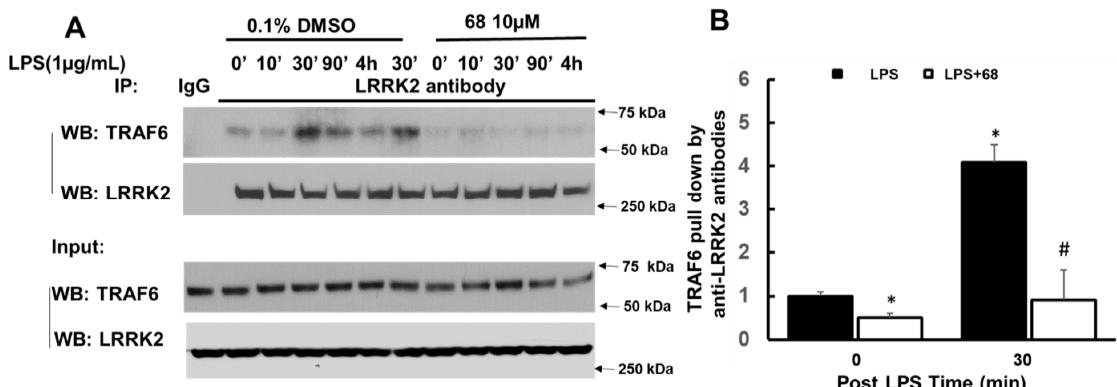
Figure 4. Compound 68 reduced LPS-induced TRAF6 and LRRK2 interaction. Human lymphoblasts were incubated in serum-free medium for 12 h and then exposed to LPS (1 µg/mL) with or without pre-treating 68 (10 µM) for 2 h, then kept treatment for various time periods as indicated. Cell lysates were harvested at the indicated time points after LPS exposure, then were subjected to co-IP assays using an anti-LRRK2 antibody, followed by anti-TRAF6 and anti-LRRK2 immunoblotting. LRRK2 antibody pulled down TRAF6. LPS increased LRRK2 interaction with TRAF6, while 68 attenuated this interaction. ( A ) Representative blots from the three separate experiments. ( B ) The quantification of LRRK2 interaction with TRAF6 at 30 min post LPS exposure (peak time). * p < 0.05 by ANOVA, vs. untreated cells at 0 min # p < 0.05 by ANOVA, vs. cells at 30 min post LPS exposure.